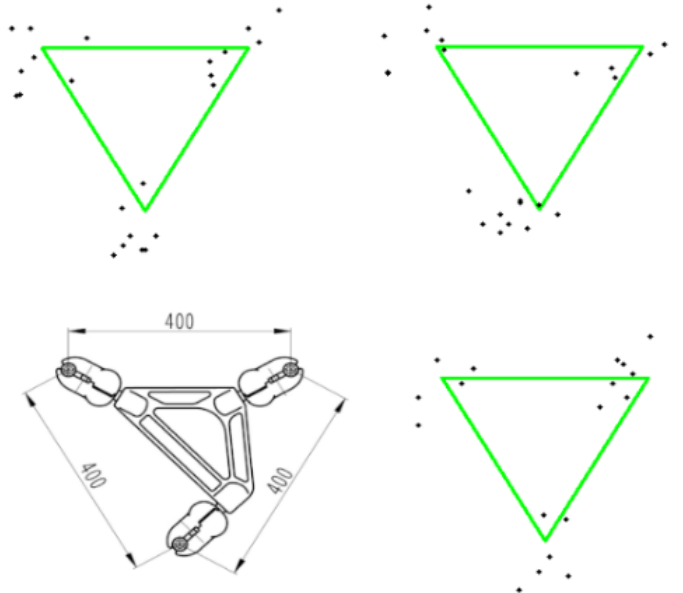
Figure 10. Illustration of the individual ACSR conductors in the bundle from the point cloud.